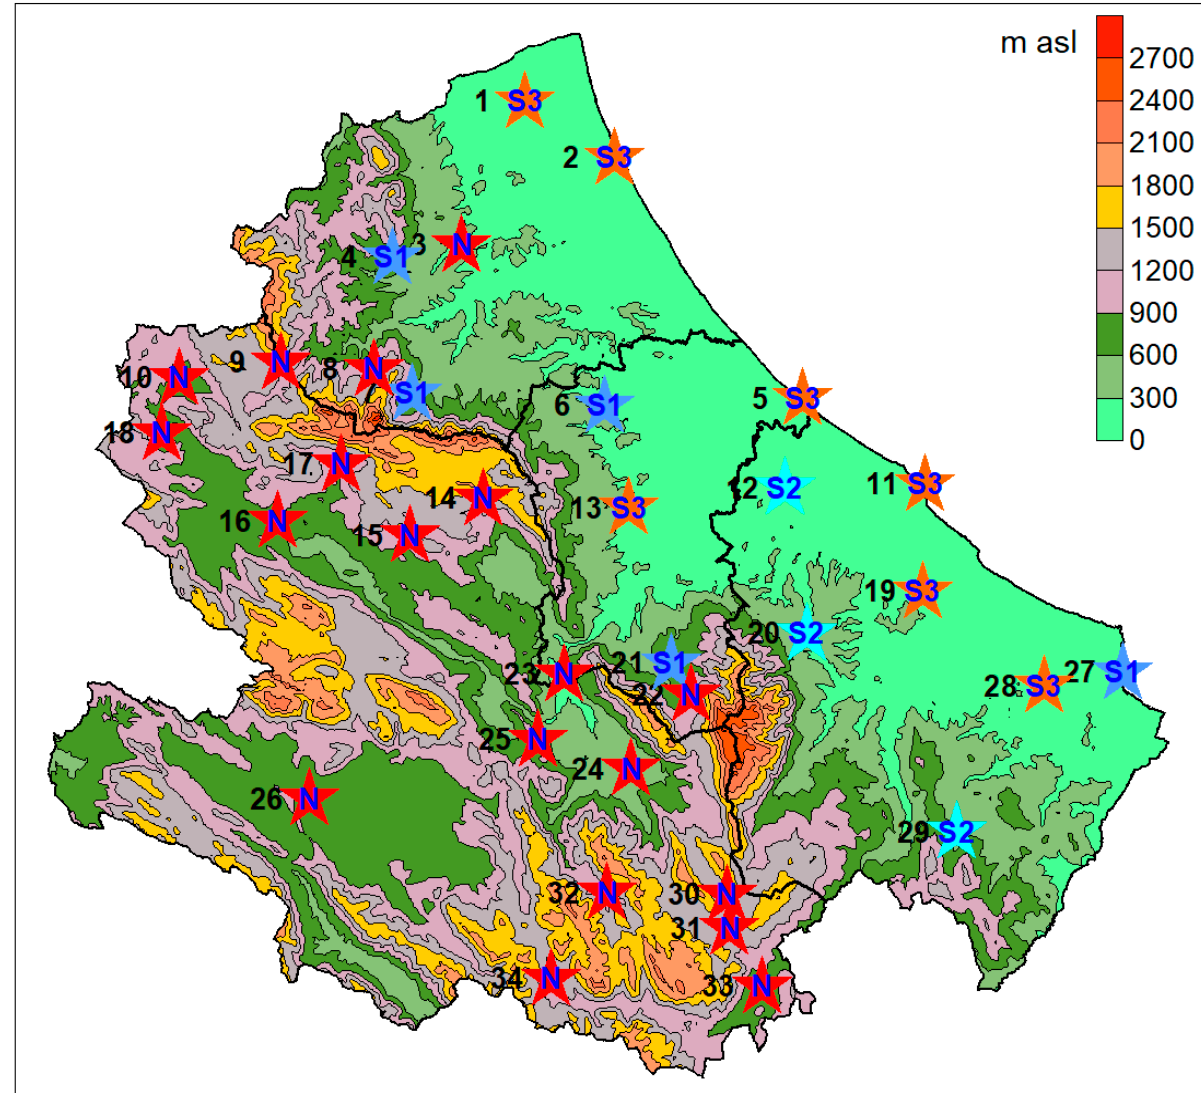
Figure 2. Agro-climatic suitability map (reference period 1980–2019), where S1 indicates an area suitable for hazelnut cultivation, S2 moderately suitable, S3 not very suitable, and N unsuitable, with numeric codes of the 34 meteorological stations on the left of each letter of suitability and with the altitude classes given on the upper right.